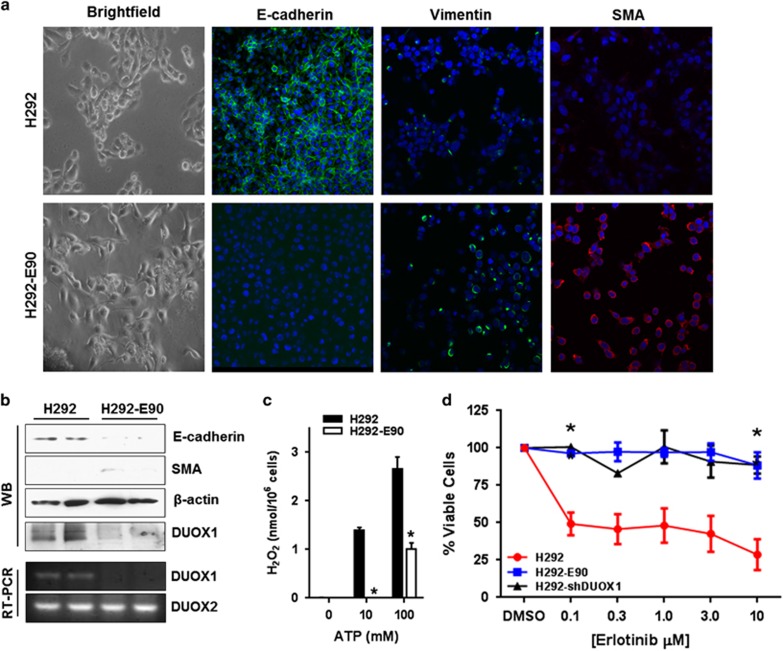
DUOX1 silencing is associated with acquired resistance to the EGFR TKI, erlotinib. (a) Brightfield and fluorescent confocal imaging of host cell line H292 and erlotinib-resistant H292 cell model (H292-E90) displaying features of EMT. (b) Protein and RNA analysis of EMT markers. (c) High-performance liquid chromatography H2O2 measurements of ATP-stimulated H292 and H292-E90 cell lines. (d) Percentage of viable cells post treatment of chemotherapeutic, erlotinib. *P<0.05 and **P<0.01 were calculated by one-way analysis of variance or Student's t-test.